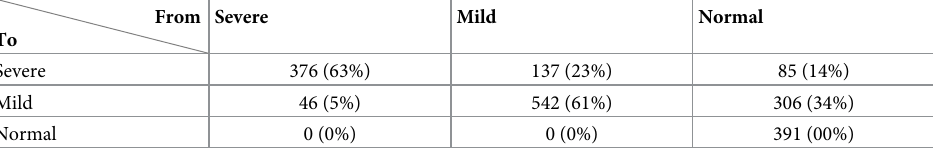
Table 2. Shows the transitions probability matrix computed from data with various states of neonatal hypother- mia in the first three hours. From Severe Mild To